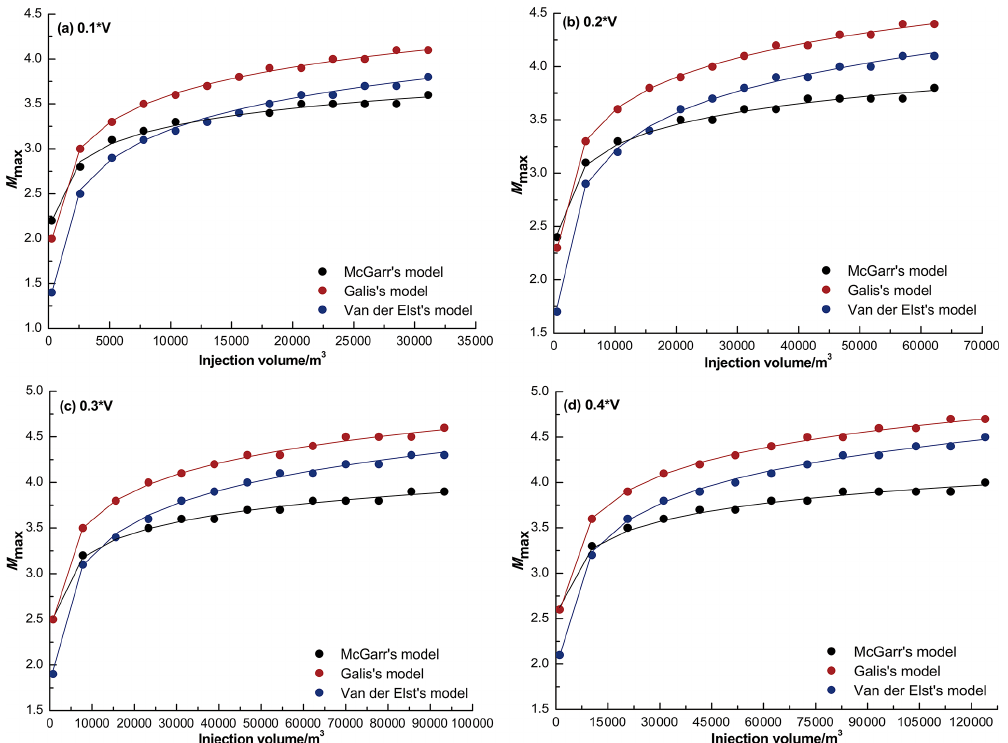
Figure 17. The maximum moment magnitude of injection-induced seismicity within ∼ 10–15km of the injected wells in response to monthly time series of injection volume in the MTY EGS field. In the calculation, the monthly injection volumes ( V ) are taken as 2 . 59 × 10 3 , 2 . 59 × 10 4 , 5 . 18 × 10 4 , 7 . 78 × 10 4 , 1 . 04 × 10 5 , 1 . 30 × 10 5 , 1 . 56 × 10 5 , 1 . 81 × 10 5 , 2 . 07 × 10 5 , 2 . 33 × 10 5 , 2 . 59 × 10 5 , 2 . 85 × 10 5 , and 3 . 11 × 10 5 m 3 , corresponding to a fluid injection rate of 1, 10, 20, 30, 40, 50, 60, 70, 80, 90, 100, 110, and 120Ls − 1 ,